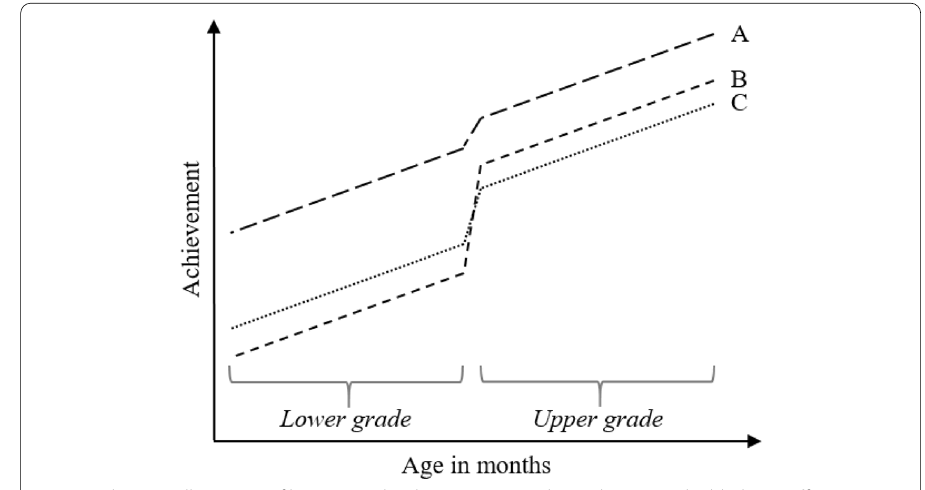
Fig. 2 Schematic illustration of between-school variation in student selection and added-year effects. Figure displays the results of the regression (dashed lines) of achievement scores (y-axis) on age in months (x-axis) and an added year of schooling in a sample of students from two adjacent grades at three schools ( A , B , and C ). The between-school variation in the intercepts reflects differences in student selection. The between-school variation in the added-year effects (regression discontinuities) reflects unequal school